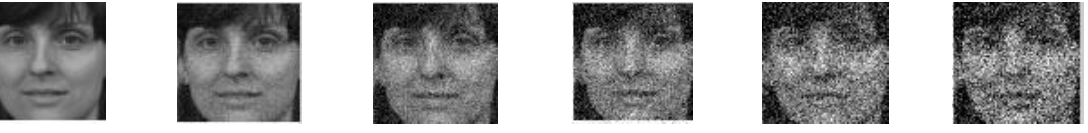
Figure 7. One test image under different levels of Gaussian noise. From left to right original image, images cluttered with Gaussian noise with variances 10, 20, 30, 40, and 50,